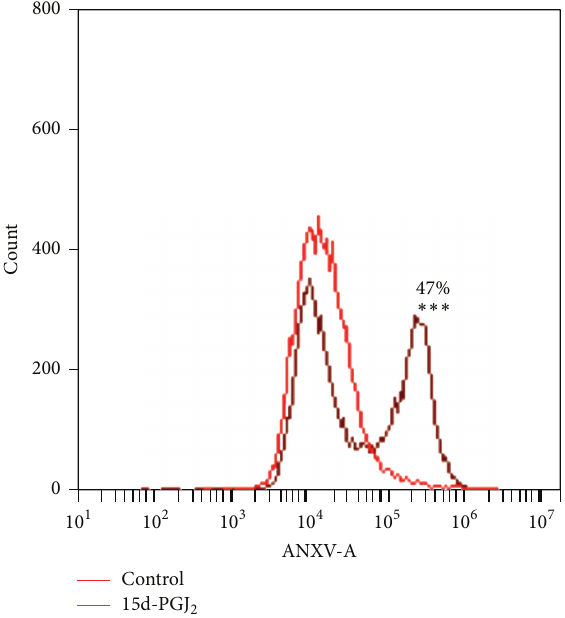
Figure 3: 15d-PGJ 2 induced apoptosis in TPC-1cells. The Annexin V assay revealed that 15d-PGJ 2 induced 47% apoptosis in TPC-1 compared to 5% in the control group. The data are presented as means ± standard deviation of three replicates from at least three independent tests. ∗∗∗ Statistically significant difference from the control ( P > 0.001